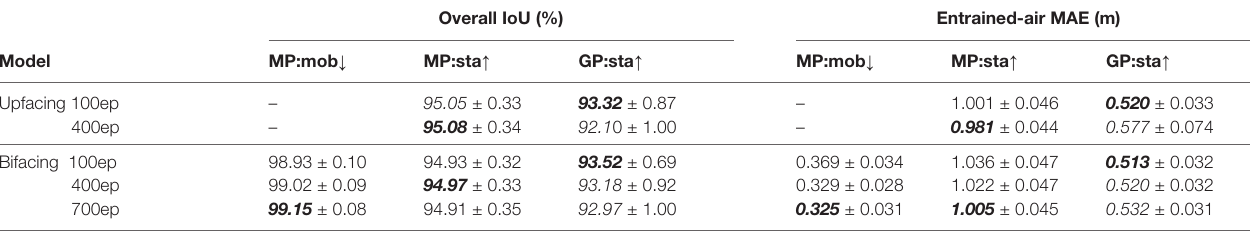
TABLE 4 | Performance of models after each training cycle (different total training